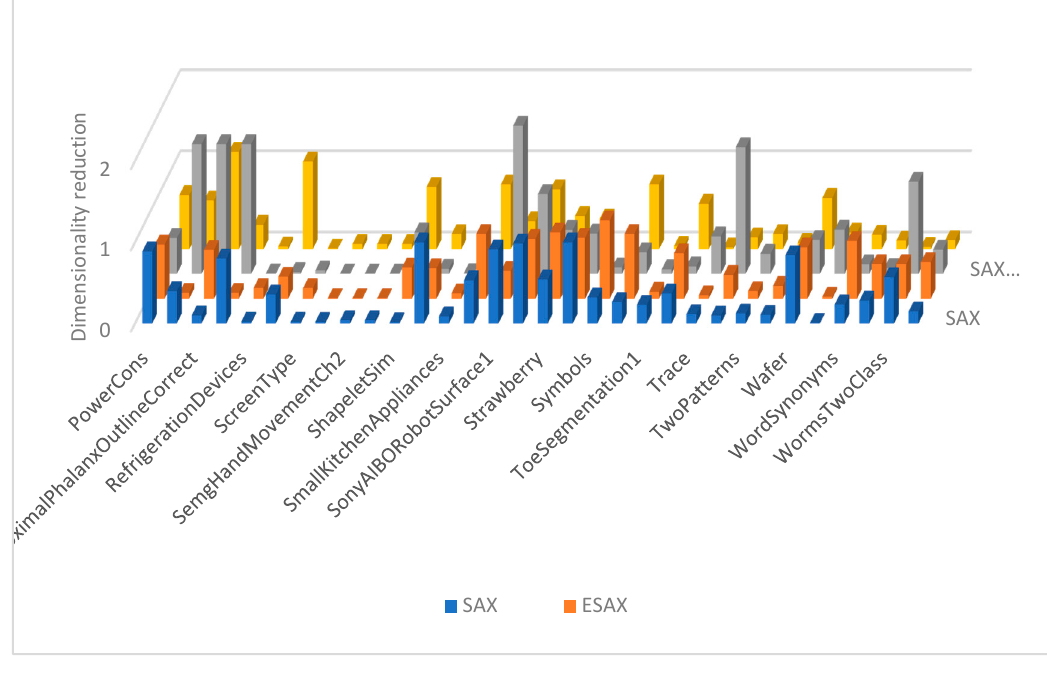
( c ) The Dimensionality reduction ratio of the four methods. Figure 8. Dimensionality reduction ratio of the four methods.